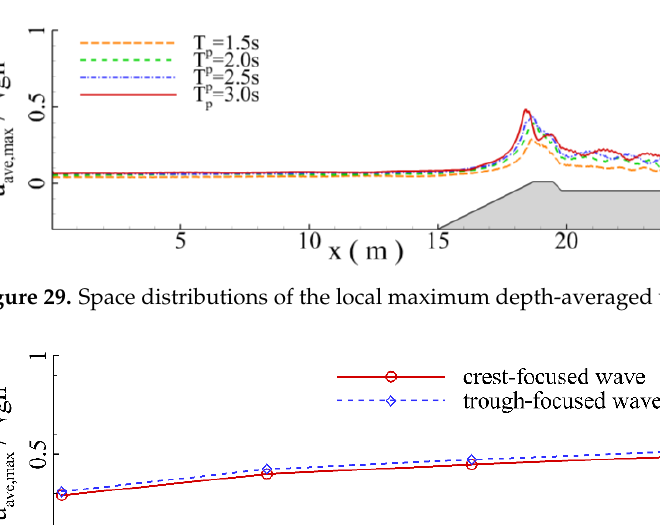
Figure 28. Space distributions of the local maximum depth-averaged velocity.